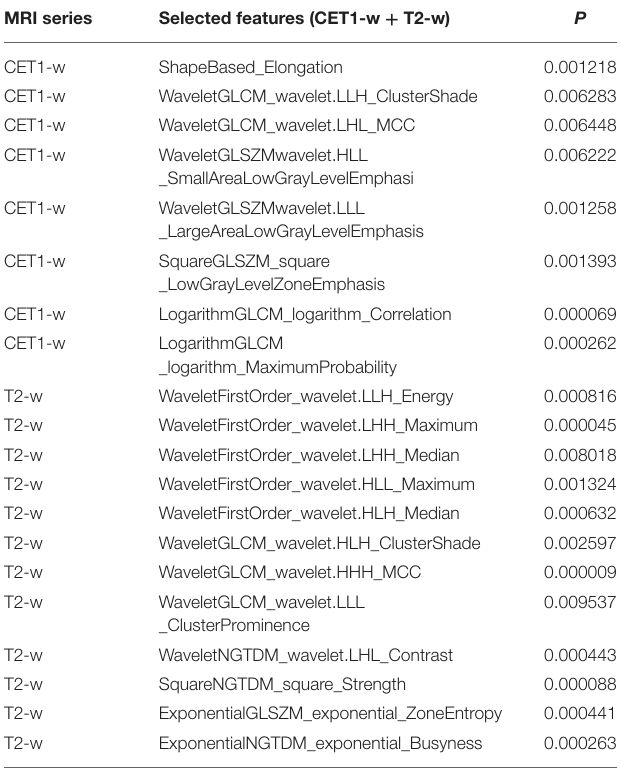
TABLE 2 | Radiomic feature selection result.